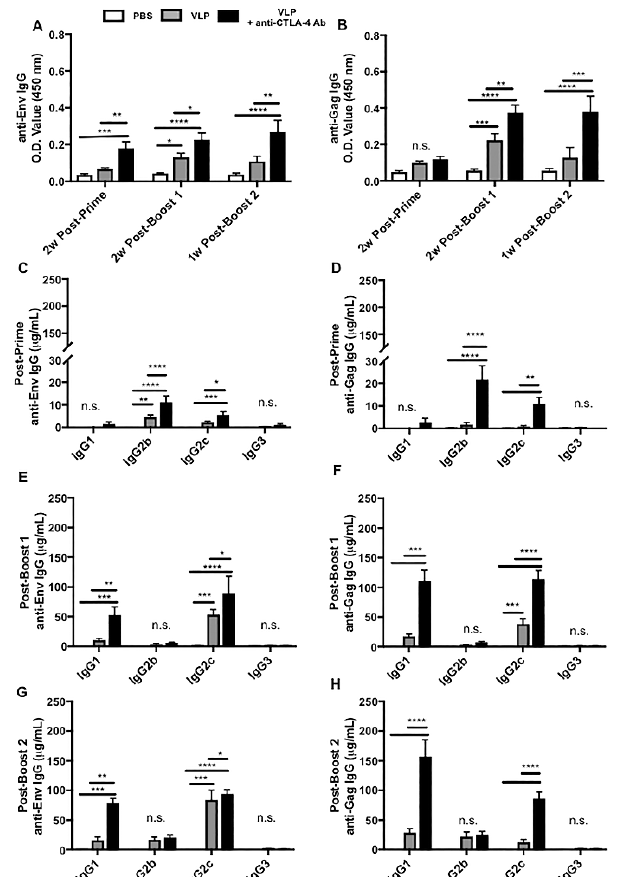
Figure 4. CTLA-4 blockade amplifies serum HIV Gag- and Env-specific antibody responses. Post-prime serum was collected 13 days after the first VLP immunization; Post-boost 1 serum was collected 11–13 days after the second VLP immunization. Post-prime and Post-boost 1 time points analyzed serum from 10 mice per immunization group from Cohorts 1 and cohorts 2. The Post-boost 2 time point analyzed serum from the 15 mice (5 per group) in Cohort 2 and was collected 7 days after the third VLP immunization. ( A ) Total Env-specific IgG and ( B ) total Gag-specific IgG were analyzed through ELISA. Quantitative ELISAs with standard curves for IgG1, IgG2b, IgG2c, and IgG3 were performed on all serum samples from Cohorts 1 and 2 to detect HIV Env- and Gag-specific IgG subtypes. Shown at each of the following time points: ( C ) post-prime, ( D ) Env post-prime Gag, ( E ) post-boost 1 Env, ( F ) post-boost 1 Gag, ( G ) post-boost 2 Env, and ( H ) post-boost 2 Gag IgG subtypes. The results above are the cumulative results of two independent experiments. P-values were determined by one-way ANOVA and Tukey post-hoc analysis for multiple comparisons. A line on top of two groups indicates statistical differences between these two groups. **** p < 0.0001, *** p < 0.001, ** p < 0.01, * p < 0.05, and n.s. p > 0.05.